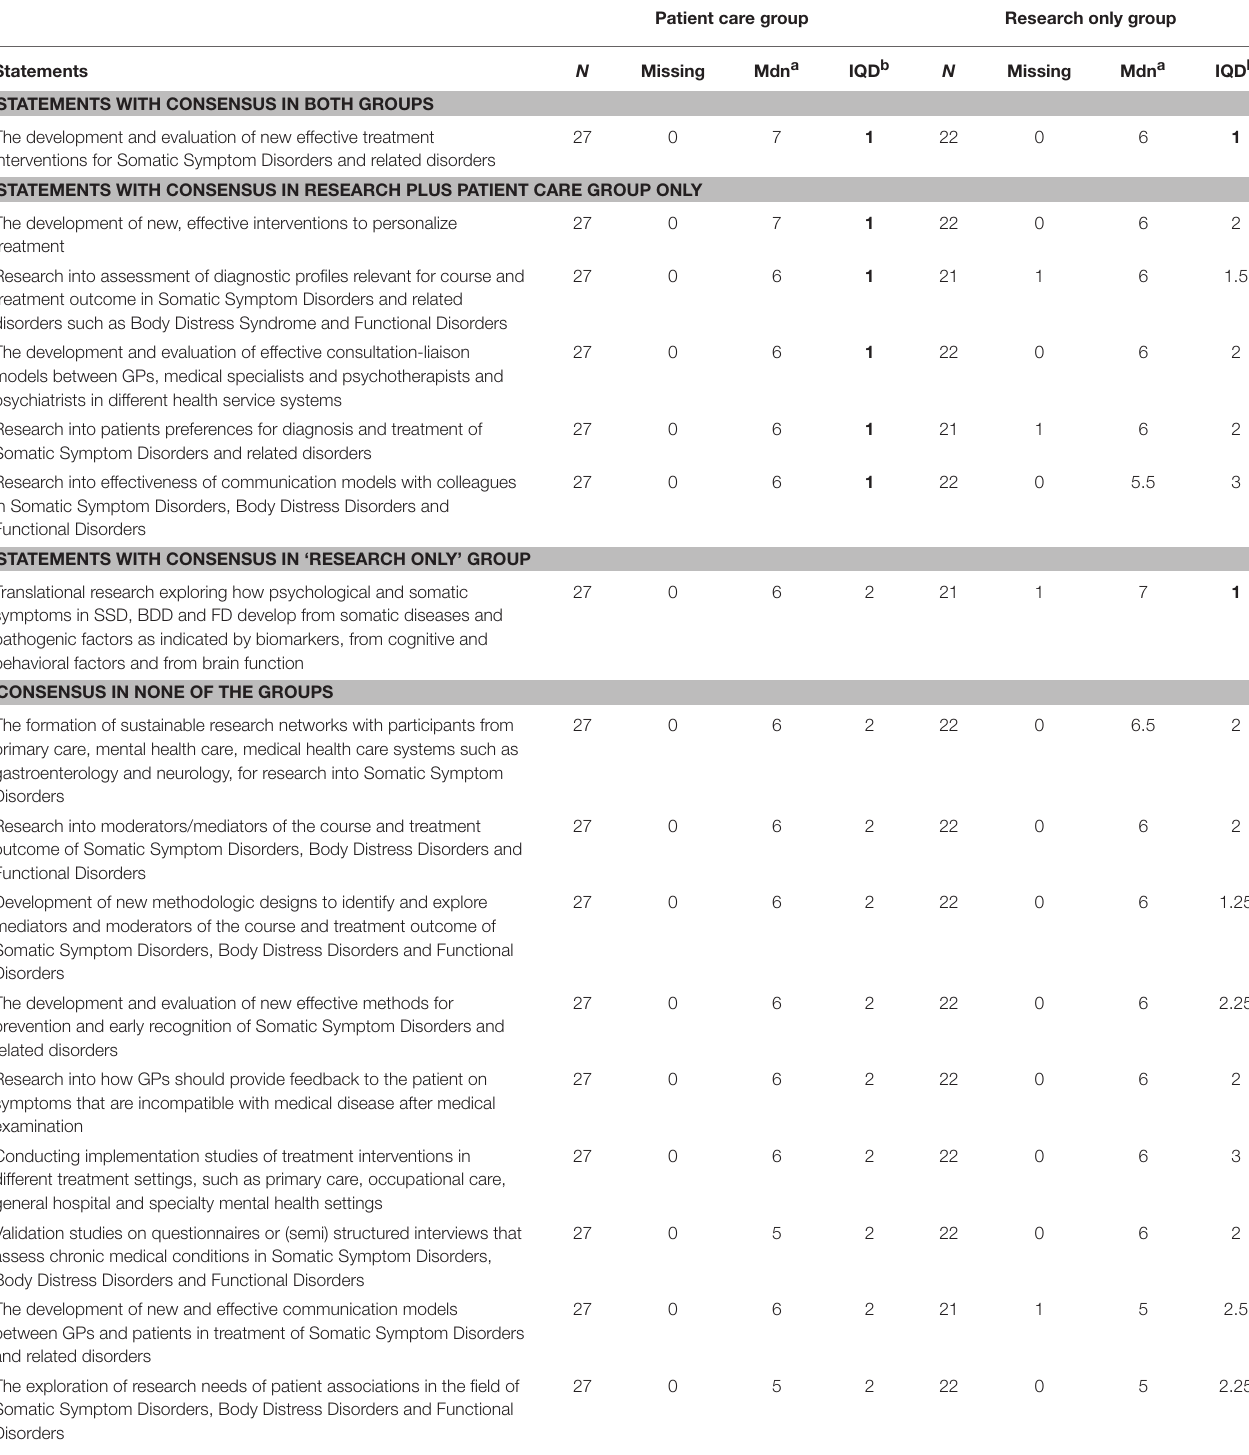
TABLE 3 | Sensitivity analysis.